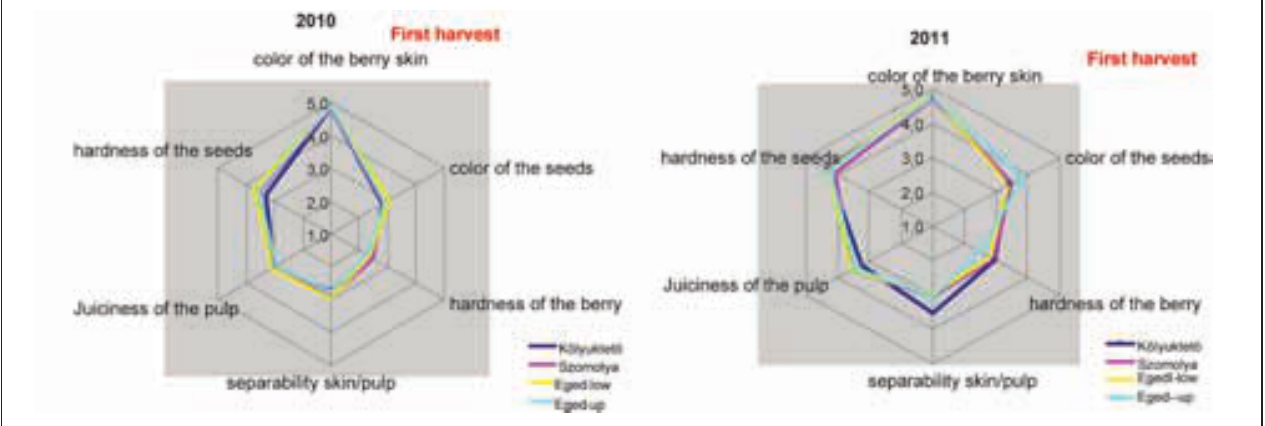
Figure 3 a: Main physical parameters of the berry (2010-2011-First harvest time)